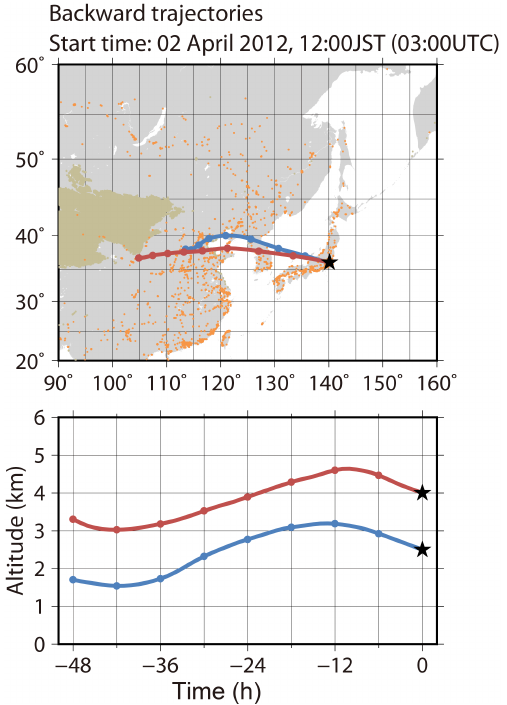
Figure 18. Two-day backward trajectories of air masses observed on 2 April 2012. The ochre region and orange areas in the upper panel indicate desert region and urban regions,